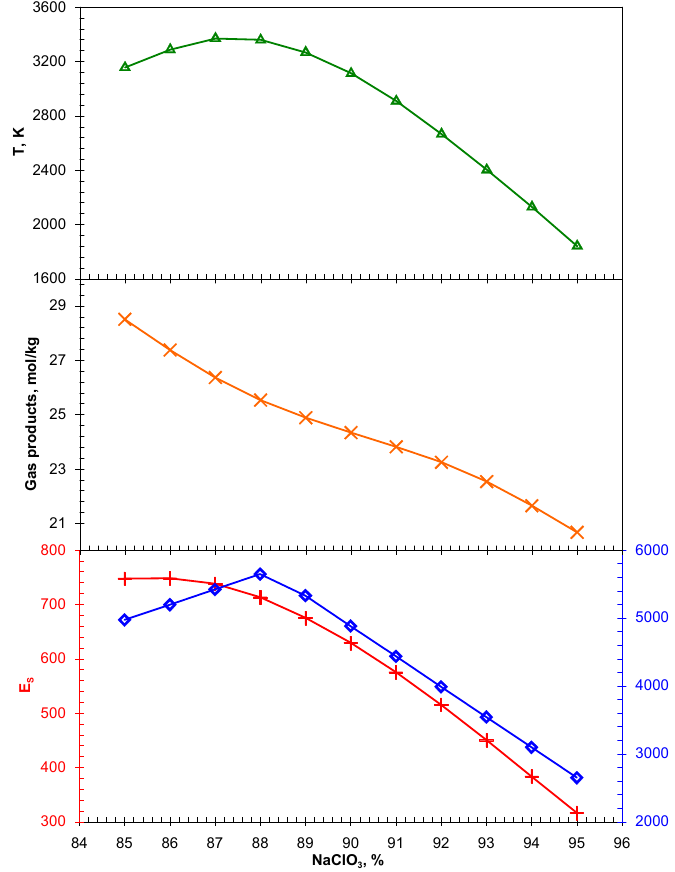
Figure 3. Relationship between thermodynamic parameters of tested mixtures and content of sodium chlorate (V).